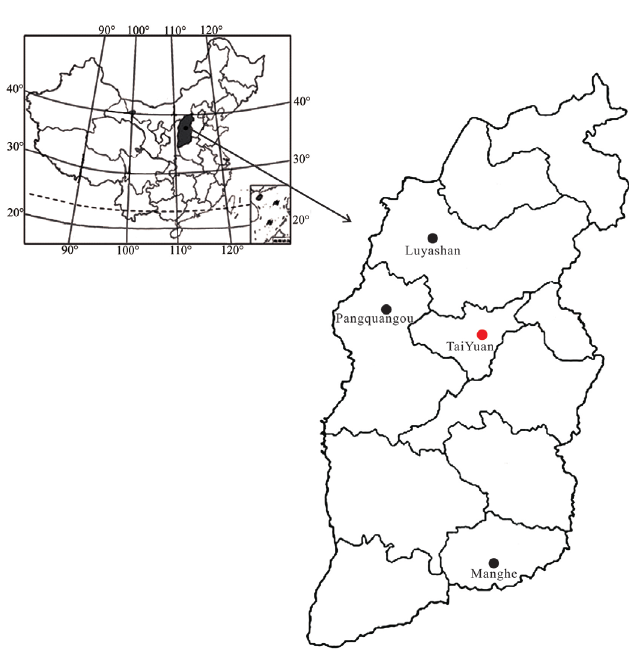
Fig. 3: Geographical sites of Manghe, Pangquangou and Luyashan Nature Reserves, showing relative location of three provenances in Shanxi